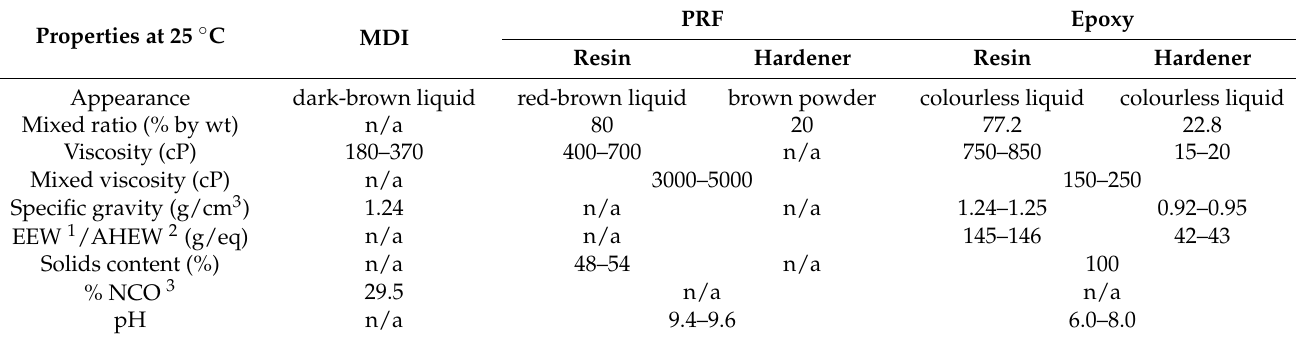
Table 1. Selected properties of MDI, PRF and epoxy